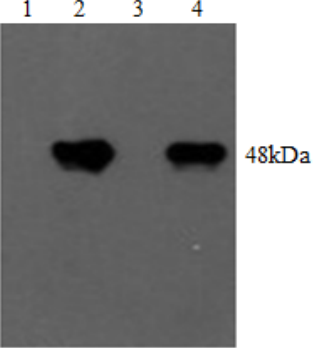
Serum antibodies against integrins were detected by western blot analysis. Immune response signals for the recombinant proteins pET- β 6-1 and pET- β 6-2 and guinea pig serum antibodies against β 6-1 and β 6-2 were both very strong (Figure 7). Figure 7. Western blot analysis of serum antibodies. Lanes 1 and 3 represent the negative control; lanes 2 and 4 represent inmmune signals for the recombinant protein pET- β 6-1 and - β 6-2 present in guinea pig anti-serum at two weeks after the second vaccination,